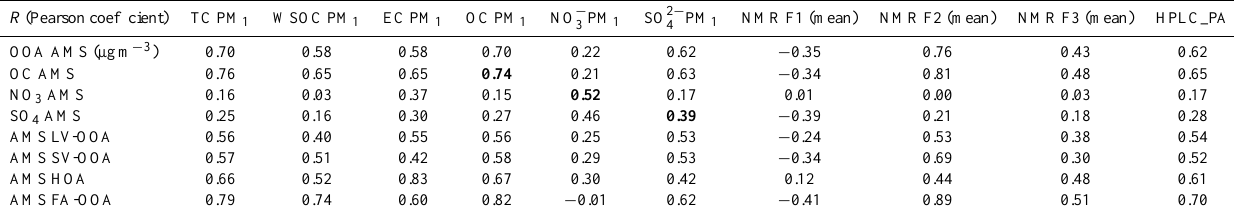
Fig. 5. Left: normalized mass spectra of the four factors, F1 to F4, (from bottom to top) determined by PMF analysis of the organic fraction of the 2008 measurements at CESAR tower. Right: time series of the PMF factors F1 to F4 (from bottom to top) determined for the organic mass fraction of the 2008 measurement period at CESAR tower. Factors (black lines, left axis) and the according tracers (coloured lines, right axes matching the respective trace in terms of colour) are given. Table 5a. Correlations between AMS analyses and chemical data from filters and NMR analyses; boxes’ colours follow the same scheme Boldface numbers highlight correlation between main aerosol components (OC, nitrate, sulfate) measured by AMS and on PM 1